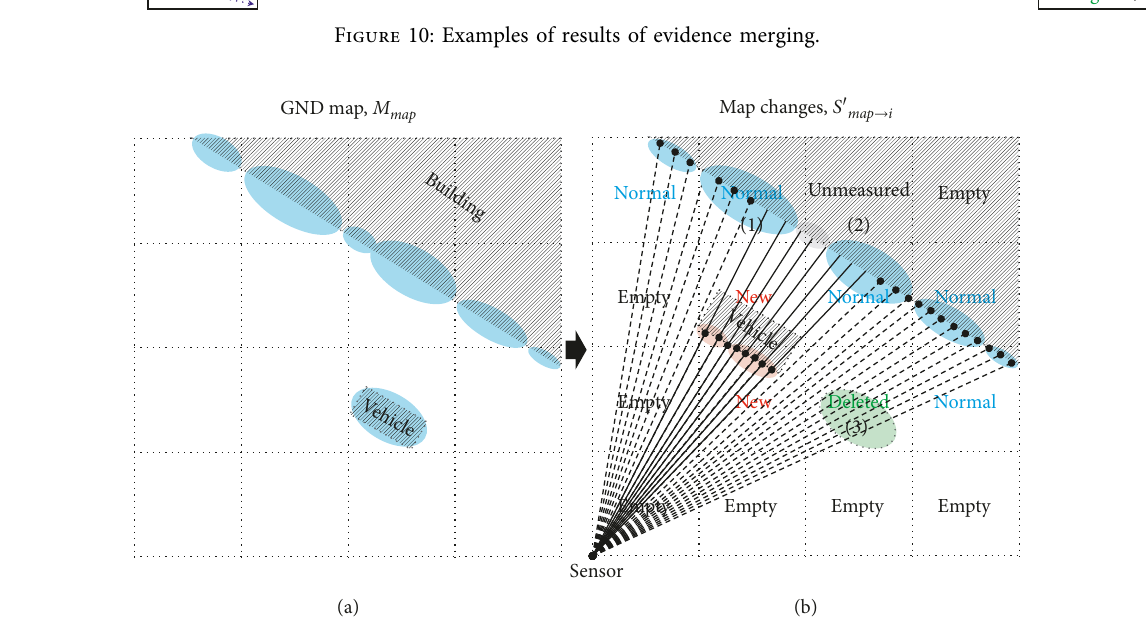
Figure 11: Map change detection based on ray-casting approach.